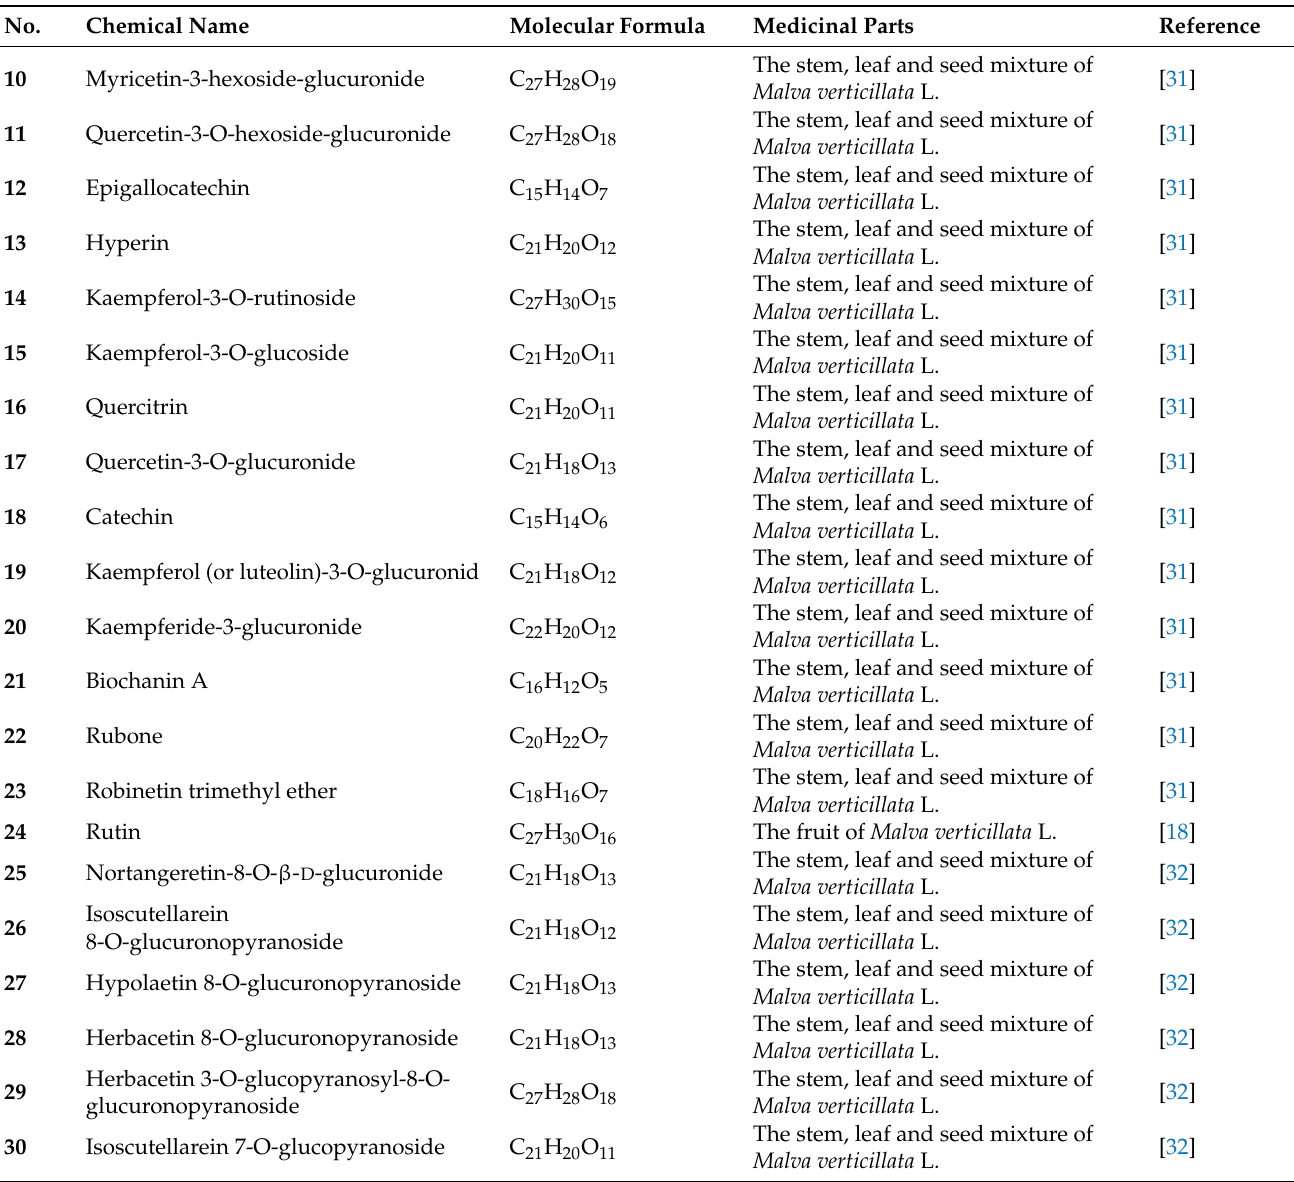
Table 2. The flavonoids identified from Fructus Malvae